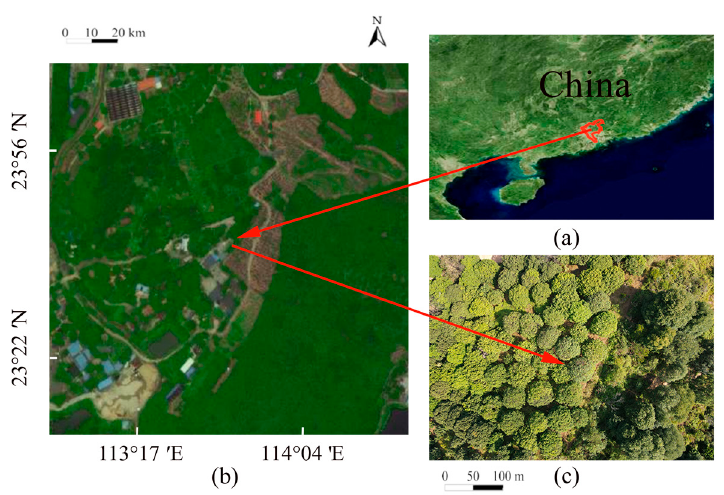
Figure 1. Study area. ( a ) Geographic location of Guangzhou within China; ( b ) location of litchi or- chard in Conghua area of Guangzhou; ( c ) top view of the litchi orchard taken by DJI Mavic Air